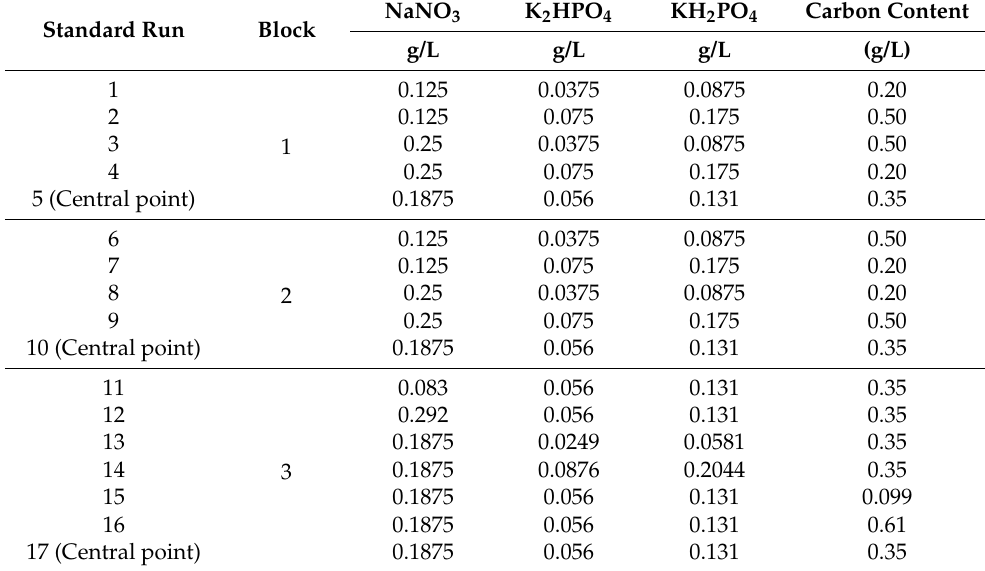
Table 2. Resolved design of